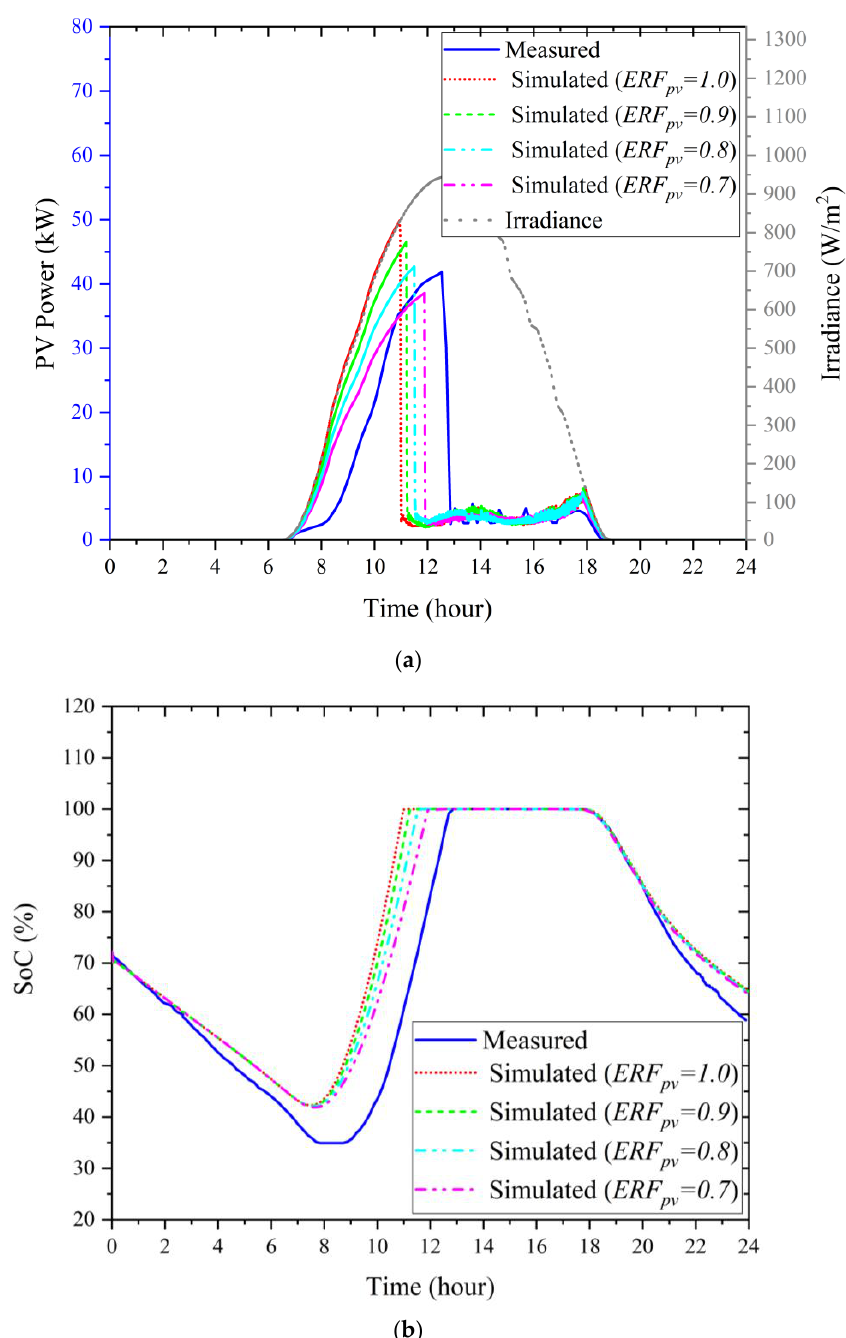
Figure 24. Validation results of PV and battery storage system: ( a ) PV output power; ( b ) battery SoC% (clear sky day).